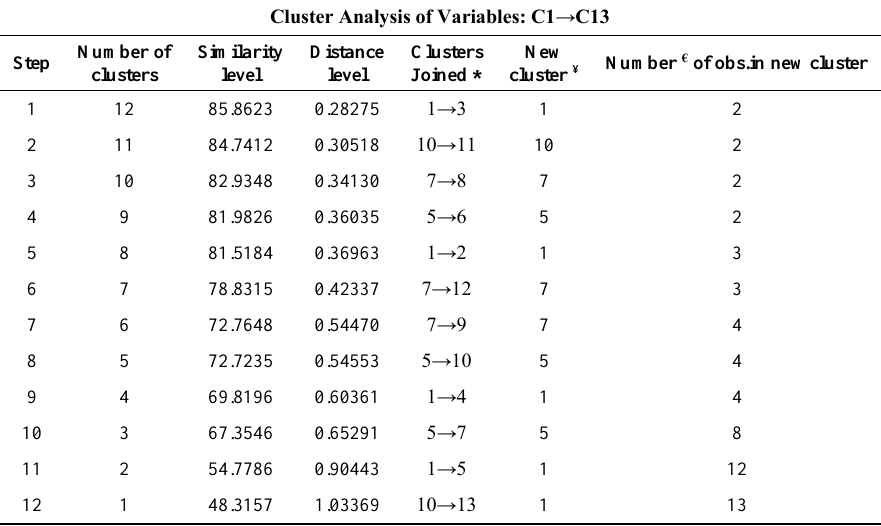
Figure 5. Spearman correlation matrix showing the degree of association of the total microbiological count between studied group of the point-of-use in a healthcare facility Table 2 showed the formation of clusters for dendrogram creation at each step and determined the similarity (or distance) levels of the clusters formed. The pattern of how similarity or distance values change from step to step could aid in the selection of the final clustering for the database [17]. The step where the values changed abruptly might be identified as an acceptable point to define the final grouping. The decision about final grouping was also called “cutting the dendrogram”. Cutting the dendrogram was akin to drawing a line across the dendrogram to specify the final clustering [17]. In this essence, the inflection between step 10 (8 observations) and 11 (12 observations) could be observed. The dendrogram (tree diagram) was used to display the groups formed by aggregation of variables at each increment and showed their similarity levels. In Figure 6, the similarity levels – which could be displayed as distance level as well - were quantified along the y-axis through measuring the corresponding horizontal line at each step and the various variables (distribution network sampling points) were listed along the x-axis. Accordingly, three cutting edge clusters could be identified viz. 1(4), 5(8) and 13(1). Table 2. Correlation Coefficient distance, complete linkage and amalgamation